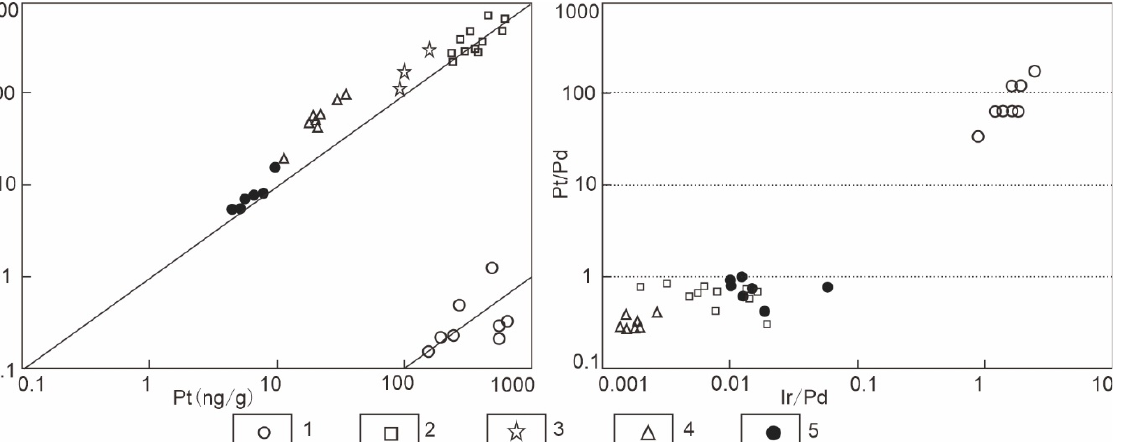
Figure 10. Pt–Pd and Pt/Pd–Ir/Pd diagram for black shale in CN outcrop. 1. Fe–Mn crusts [68]; 2. Ni–Mo ore in Guizhou [9]; 3. Ni–Mo–Zn ore, Canada [67]; 4. Cambrian black shale in Chengkou [7]; 5. CN outcrop (Section C and D).